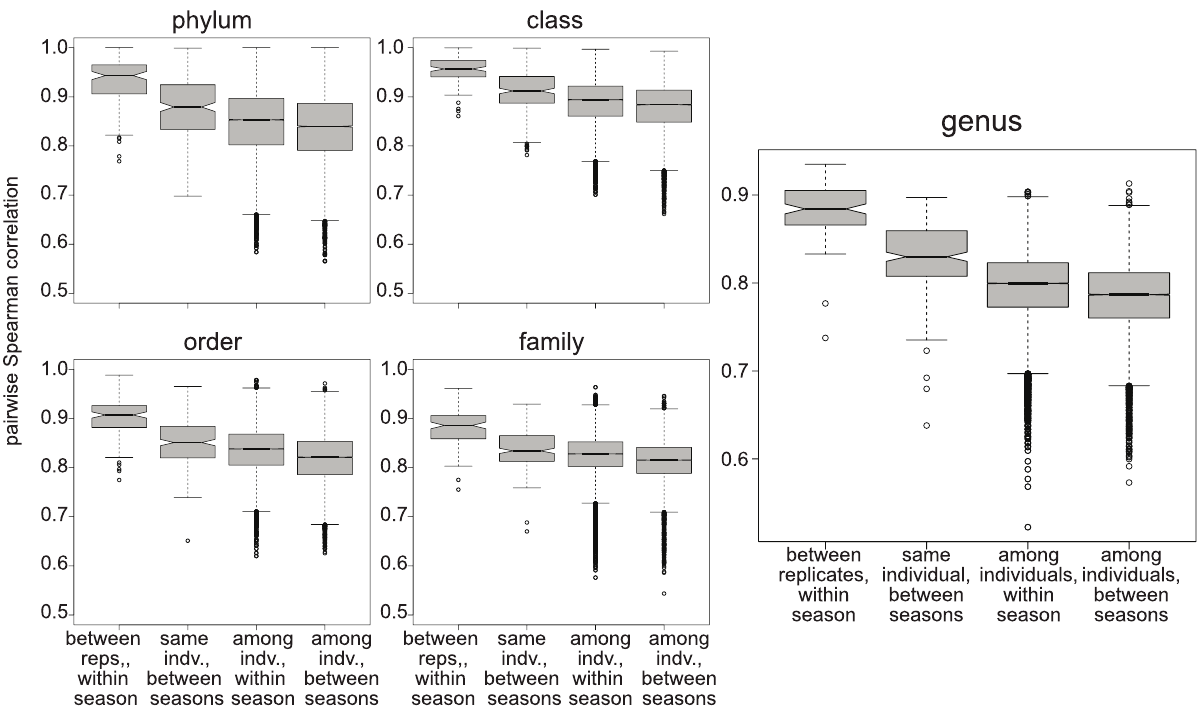
Figure 1. Correlation of microbiome composition between replicates, individuals, and over time. Boxplots of pairwise Spearman correlation (y-axis) of bacterial abundance is shown for data at each taxonomic level (x-axis) across different classification levels. ‘Replicates’ refer to technical replicates derived from separate DNA extractions and library preparations from the same sample.